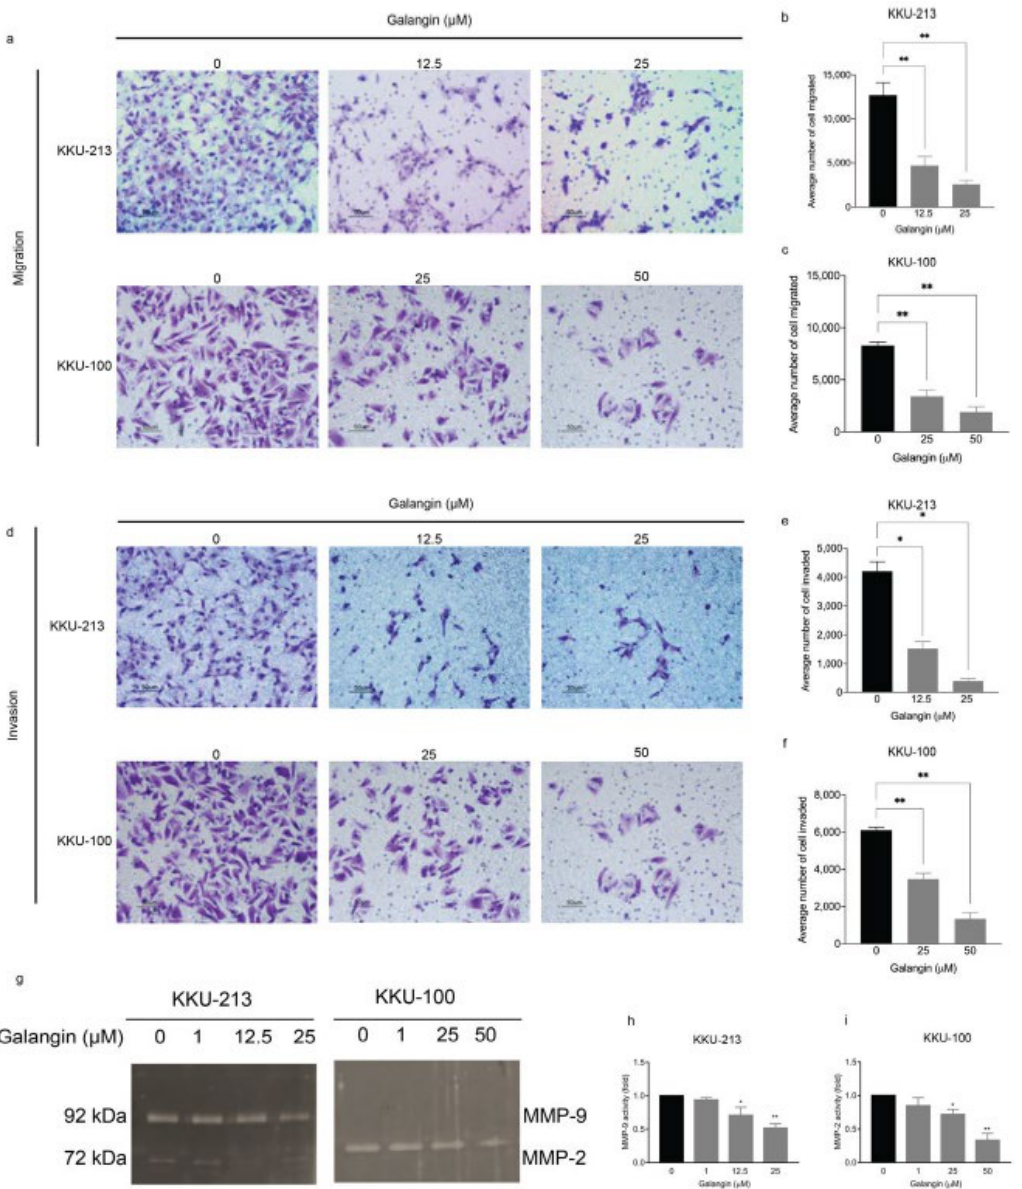
Figure 2. Effect of Galangin on migration and invasion in KKU-213 and KKU-100 CCA cells. Transwell assay was used to detect cell migration and invasion. Images were taken at 20 × magnification. Images of ( a ) cell migration, each cell group treated with various of Galangin, and their respective quantifications in ( b ) KKU-213 and ( c ) KKU-100 cells. Images of ( d ) cell invasion showing each cell group treated with various amounts of Galangin, and their respective quantifications in ( e ) KKU-213 and ( f ) KKU-100 cells. ( g ) Representative images of the gelatin zymography and ( h ) quantification the band intensity of MMP-9 activity in KKU-213 and ( i ) quantification of the band intensity of MMP-2 activity in KKU-100 after Galangin treatment in various concentrations. * p ≤ 0.05, ** p ≤ 0.01 .